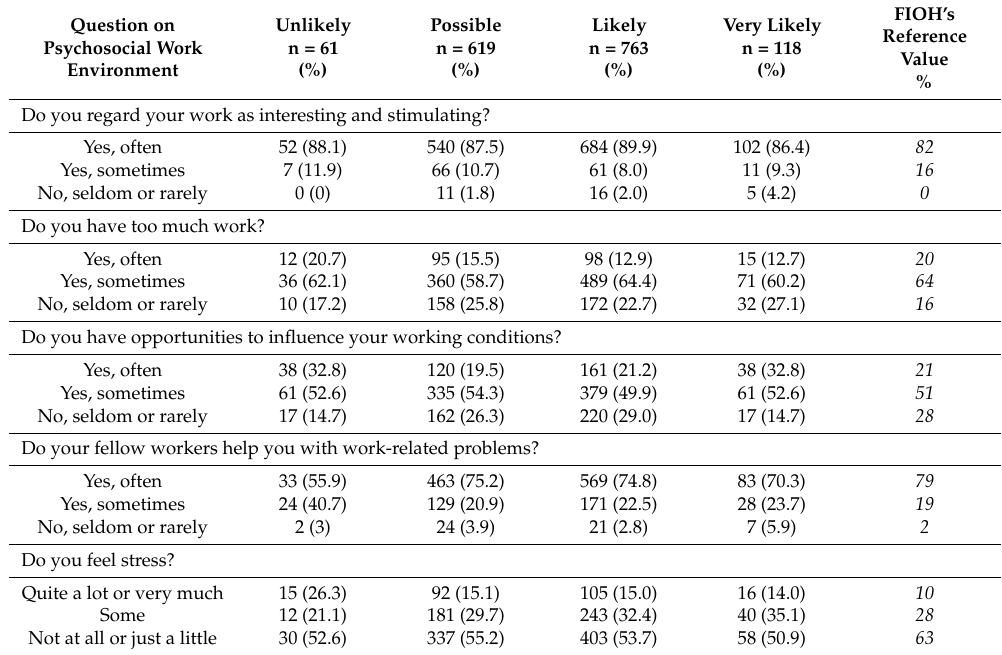
Table 4. Perceived psychosocial work environment and stress according to probability of abnormal IA exposure categories ( unlikely , possible , likely , very likely ).